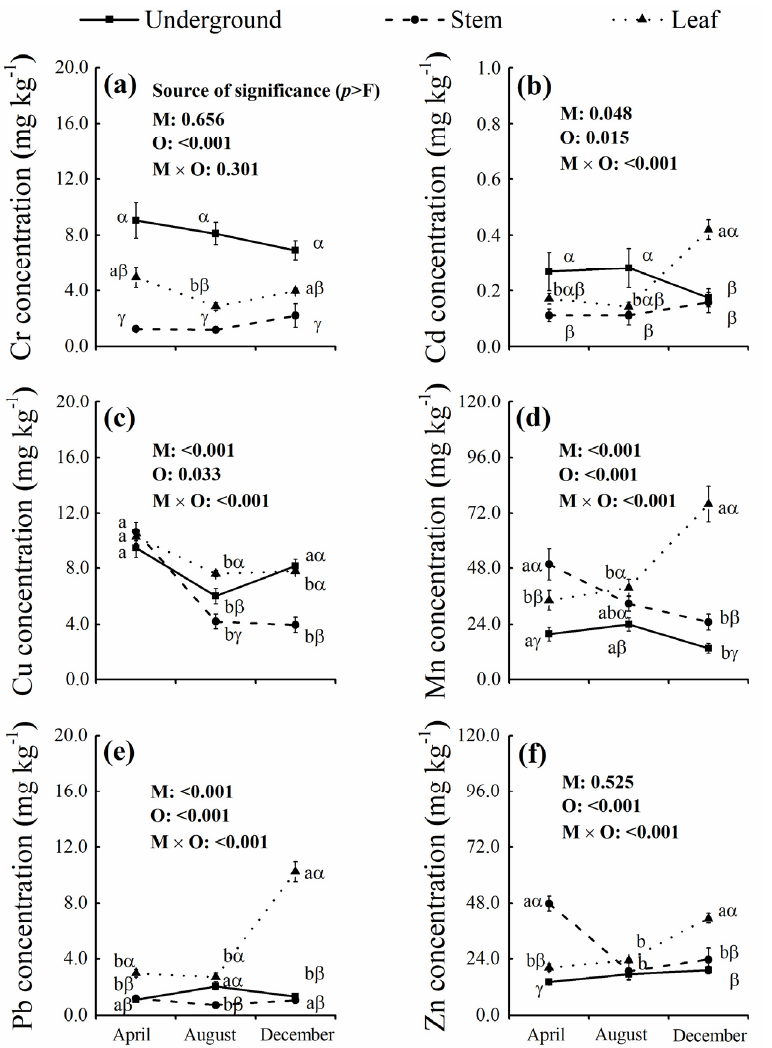
Figure 2. Seasonal changes of heavy metal concentrations in the underground organs, stems and leaves. M and O and represent sampling months and plant organs. Bars indicate standard errors of means. Different English letters indicate significant differences among the three sampling months at p < 0.05. Different Greek letters indicate significant differences among the underground organs, stems and leaves at p <